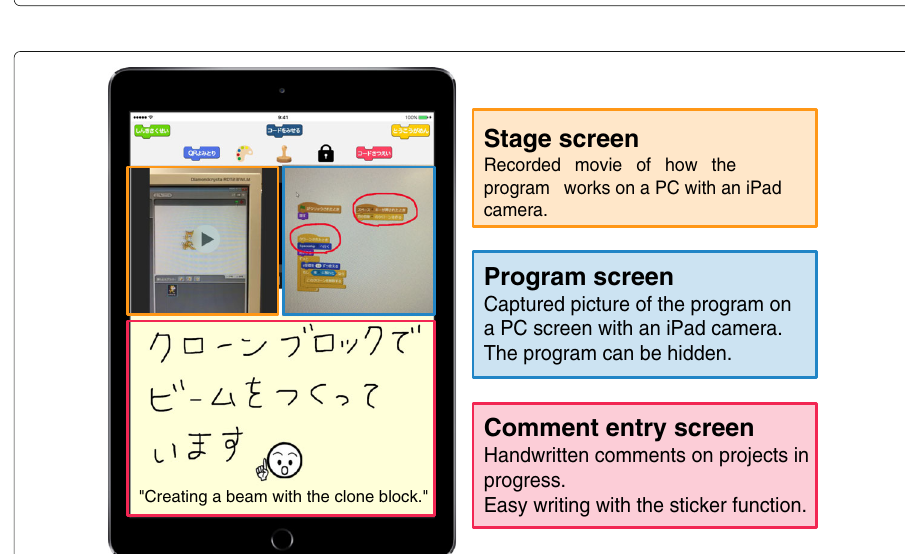
Fig. 4 Flow from posting to browsing